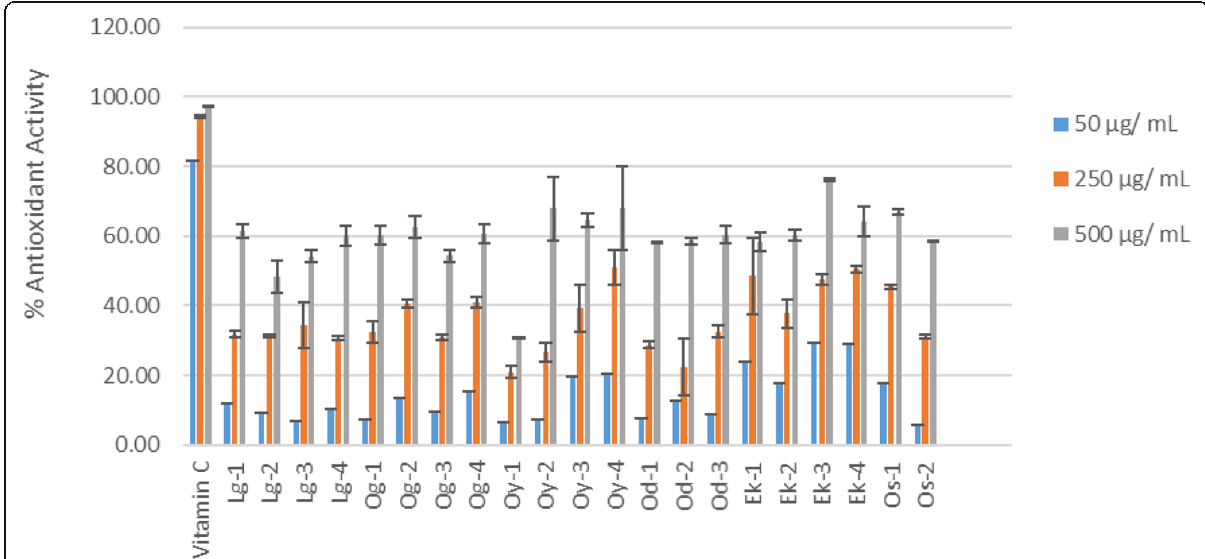
Fig. 6 DPPH radical scavenging activity of Moringa oleifera leaf from the 21 locations. The results are mean of triplicates of three different concentrations (50 μ g/mL, 250 μ g/mL and 500 μ g/mL) with the error bars (standard deviation). The chart shows significant between- and within- group differences in the DPPH content of the samples from the locations. Vitamin C, the standard used had higher scavenging activity than all the samples